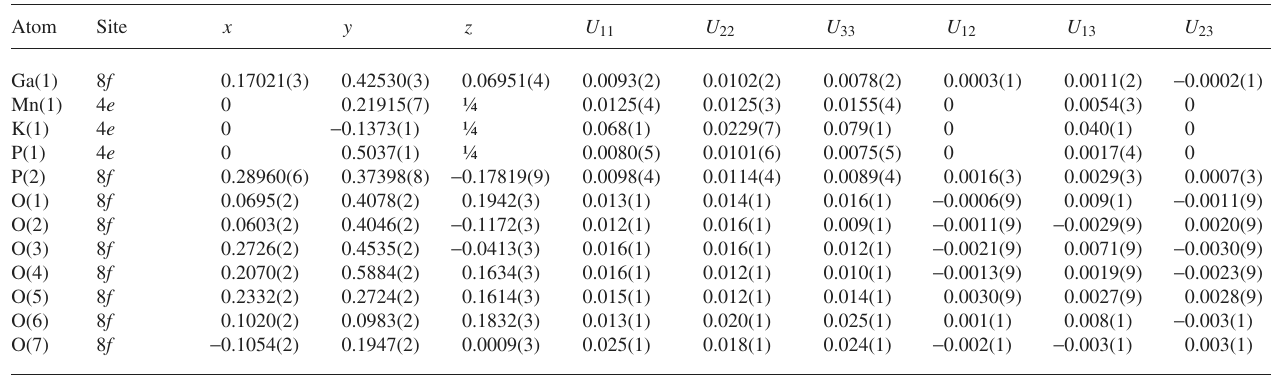
Table 3. Atomic coordinates and displacement parameters (in Å 2 ) .